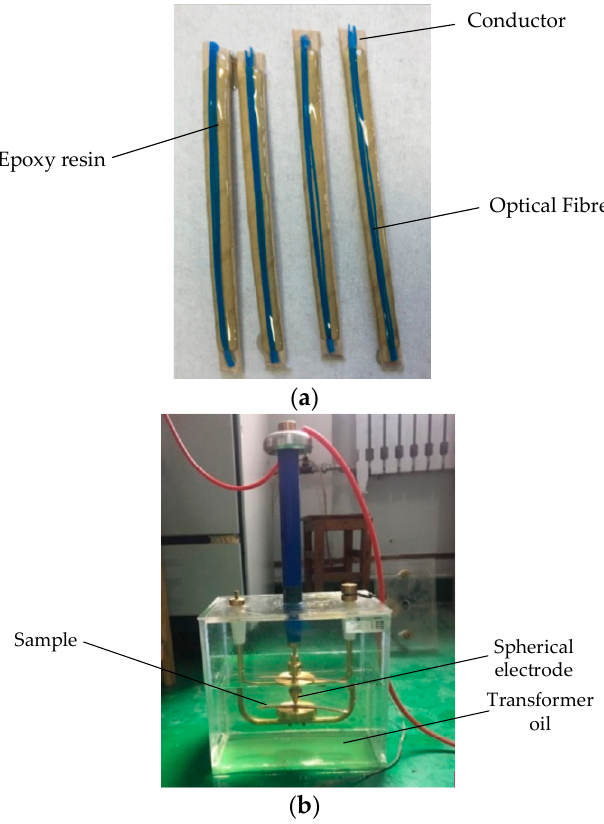
Figure 8. ( a ) Sample preparation and ( b ) breakdown voltage measuring device.